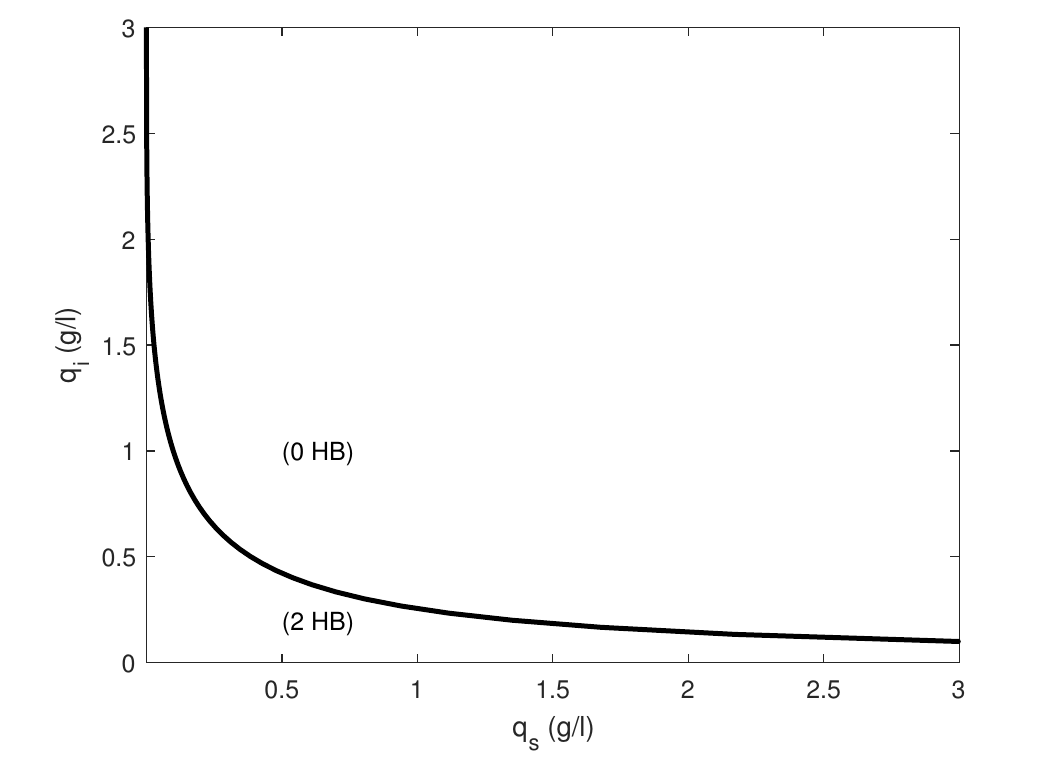
Figure 2. Curve corresponding to Equation (39) separating region (2 HB) of two Hopf points from region (0 HB) of no Hopf points.